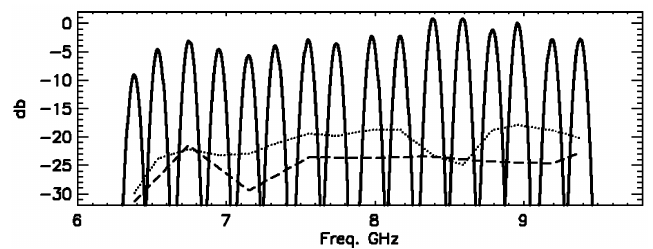
Fig. 2. Relative frequency response of the spectral polarimeter bands (solid lines), cross polarization interferences (dashed line) and system noise referred to antenna tem- perature of the quiet Sun (dotted